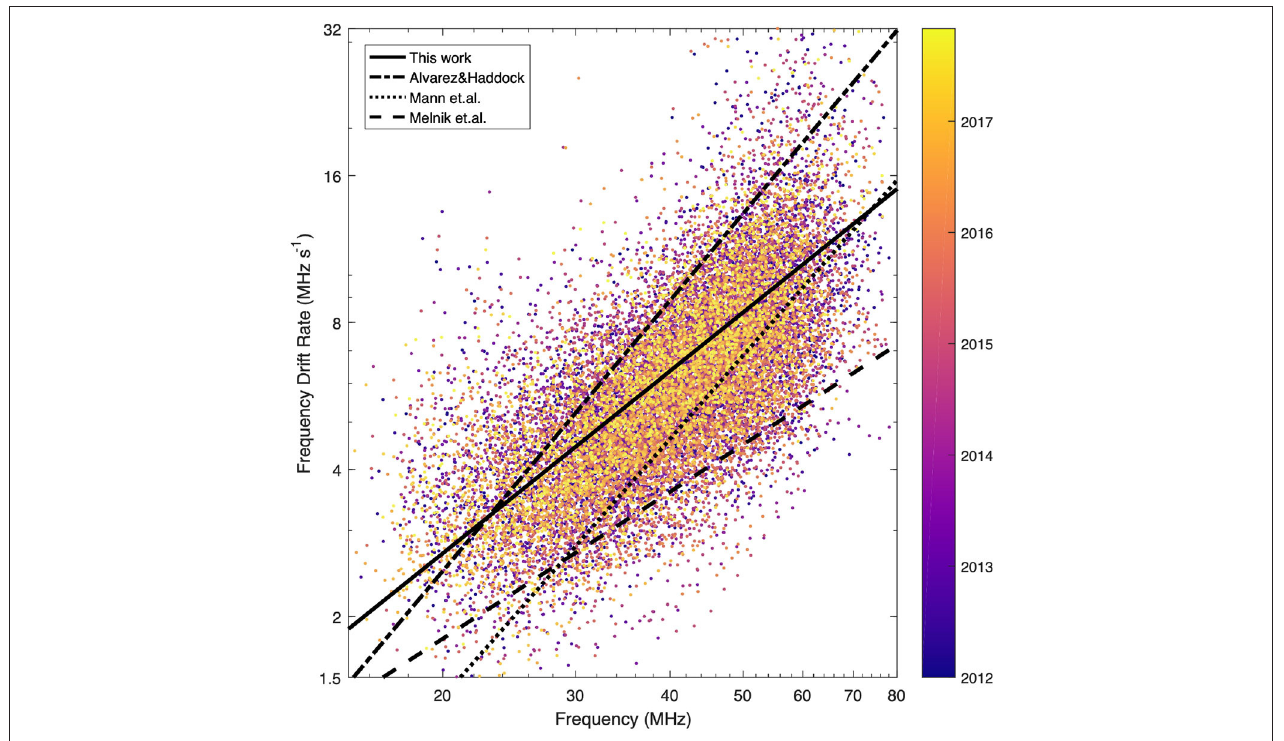
FIGURE 6 | Scatter plot of the frequency drift rate vs. frequency for 1389 simple type III bursts; the data points are color-coded according to the occurrence time of the corresponding event. The black lines indicate fitted results to the data points and from other works. From Zhang et al.